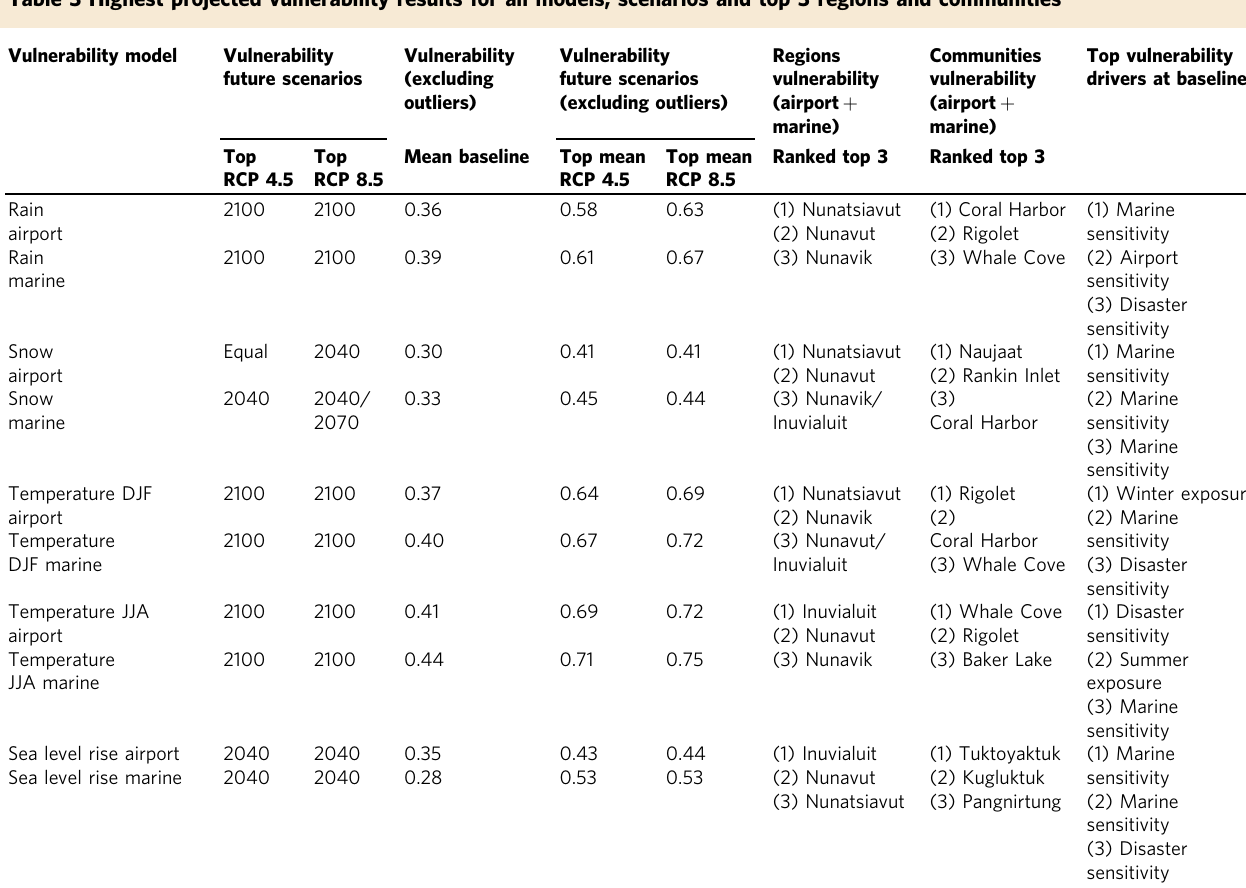
Table 3 Highest projected vulnerability results for all models, scenarios and top 3 regions and